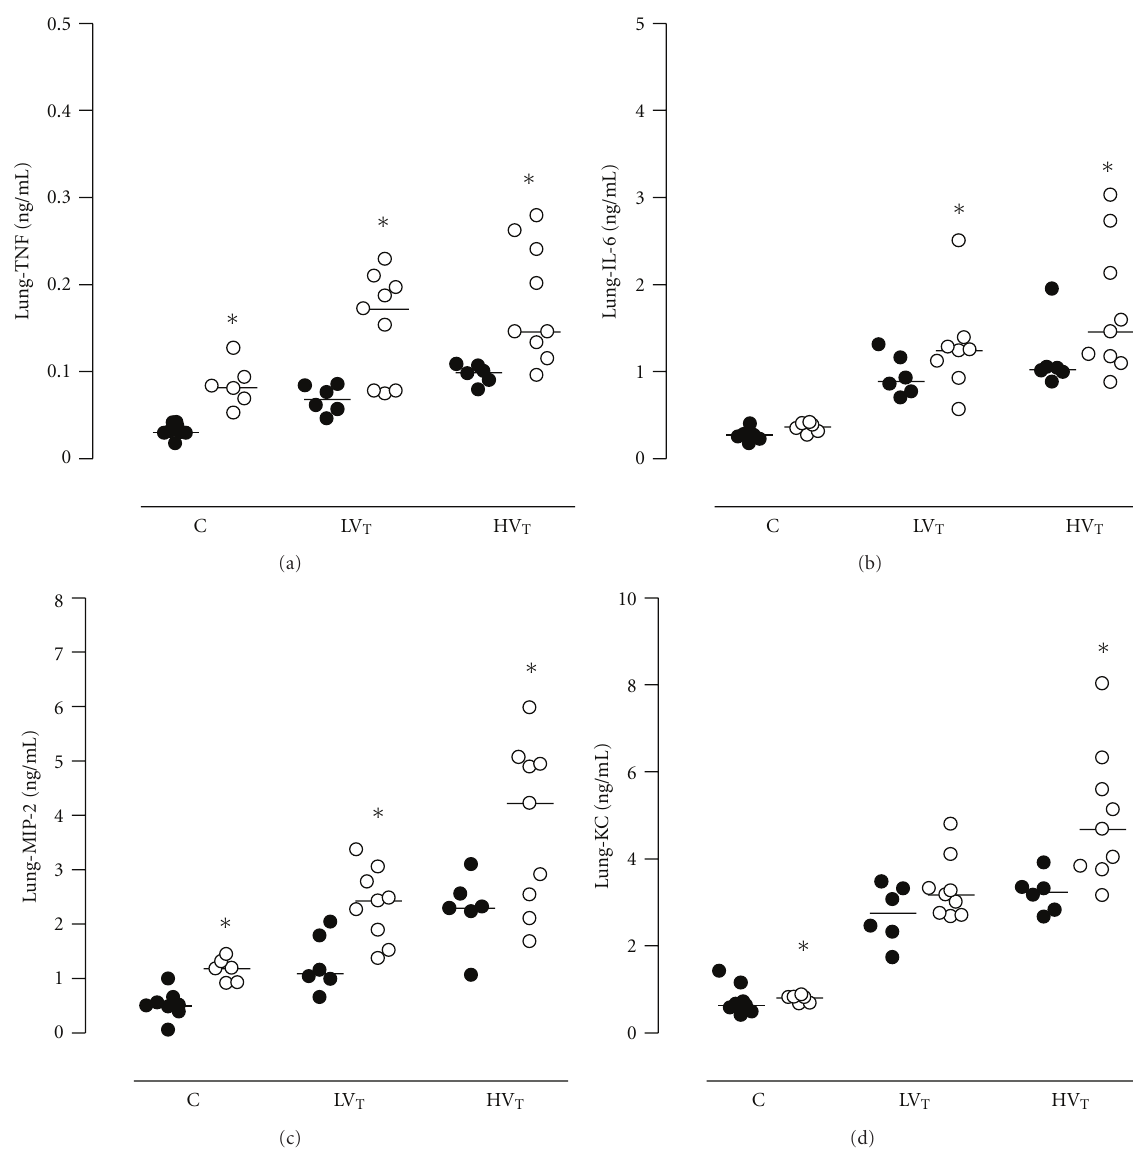
Figure 4: Pulmonary levels of tumor necrosis factor α (TNF), interleukin- (IL-) 6, macrophage inflammatory protein- (MIP-) 2, and keratinocyte-derived chemokine (KC) in lung tissue homogenate in anesthetized nonventilated control (C) mice, mice ventilated with LV T or HV T . Mice were either PAI-1 deficient (PAI-1 − / − , open symbols) or wild type (Wt, closed symbols). Data are represented as individual data with a median. ∗ indicates statistical significant di ff erence compared to